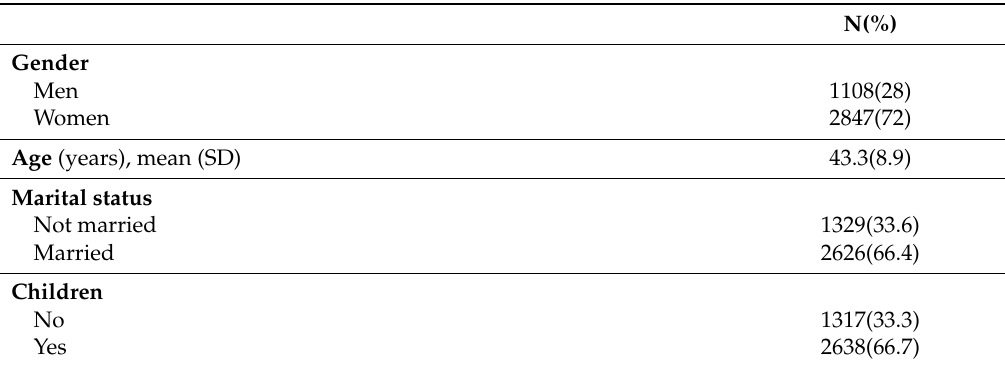
Table 1. Descriptive statistics for study